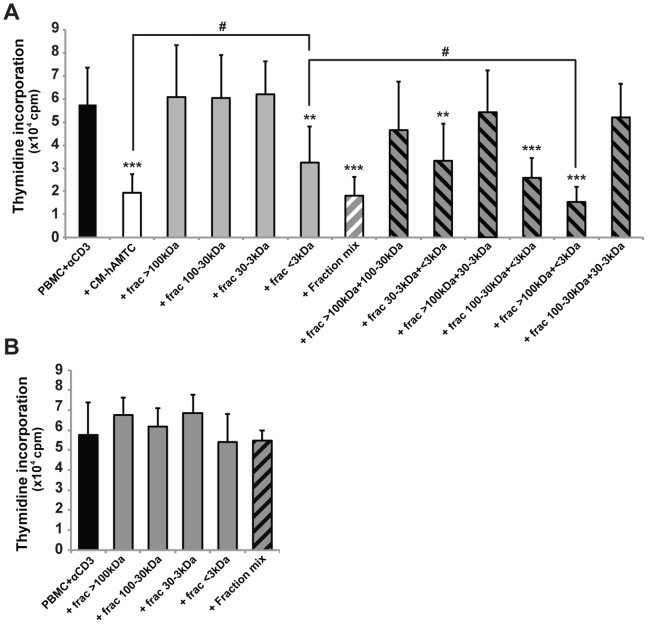
Study of the potential molecular weight of the inhibitory factor(s).(A) Lymphocyte proliferation, stimulated by anti-CD3, in presence of 100 μl of CM-hAMTC (white bar), CM-hAMTC-fraction-mix (grey bars) or mix of fractions with different molecular weights (white-grey- and black-grey-striped bars). (B) Lymphocyte proliferation, stimulated by anti-CD3, in presence of 100 μl of complete UltraCulture medium (black bar) or its fractions (grey and black-grey-striped bars). Data represent the mean and SD from at least six independent experiments. ** = p<0.01, *** = p<0.001 versus PBMC + αCD3; # = p<0.05.